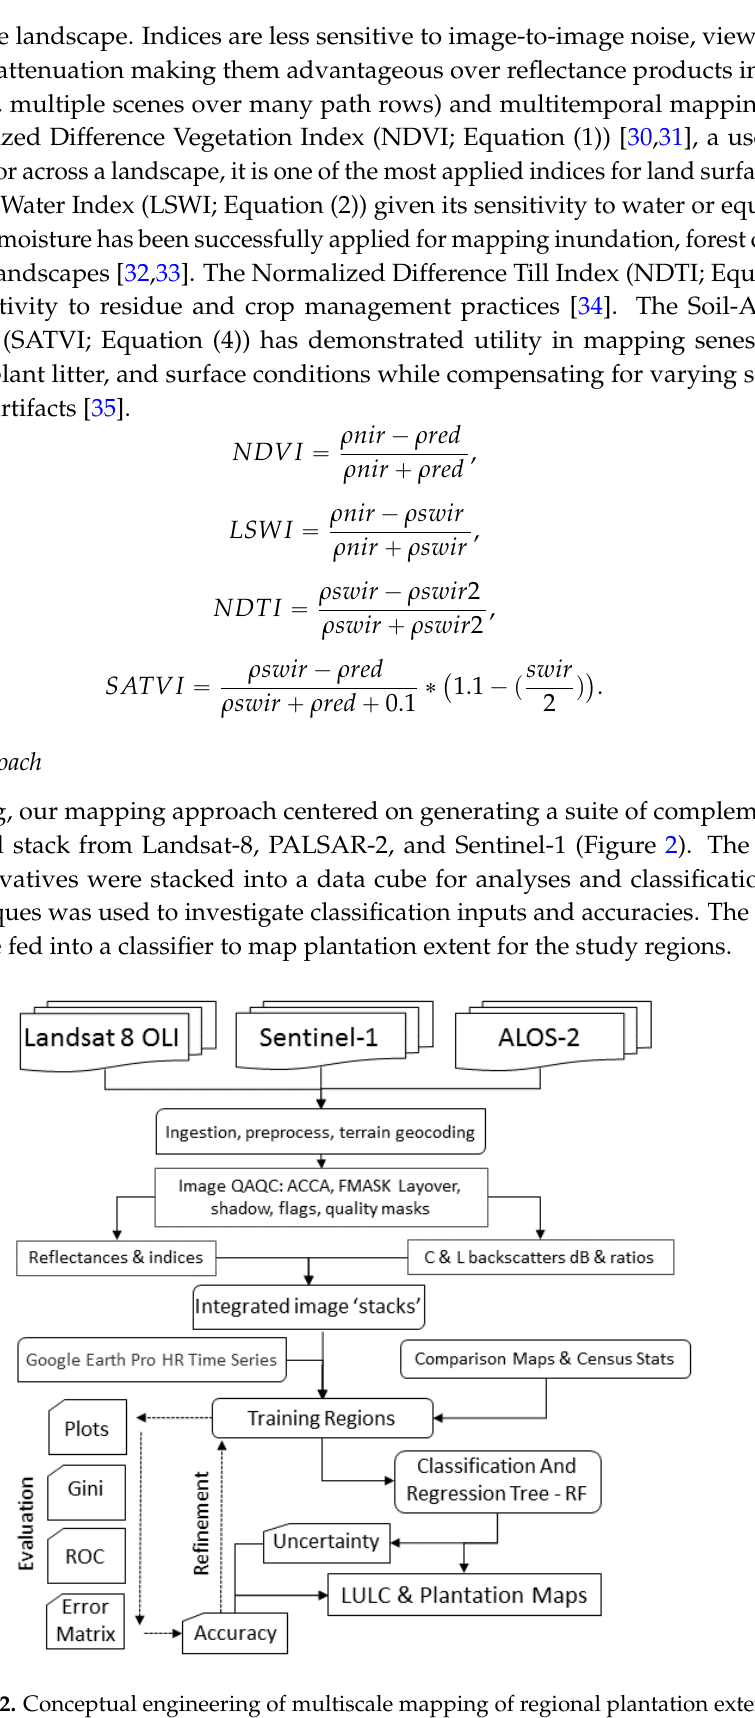
Figure 2. Conceptual engineering of multiscale mapping of regional plantation extent.